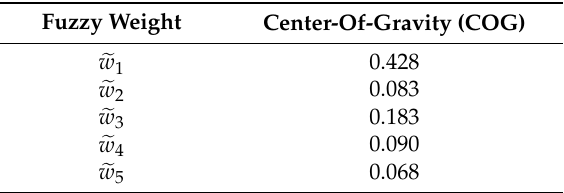
Table 3. The defuzzification